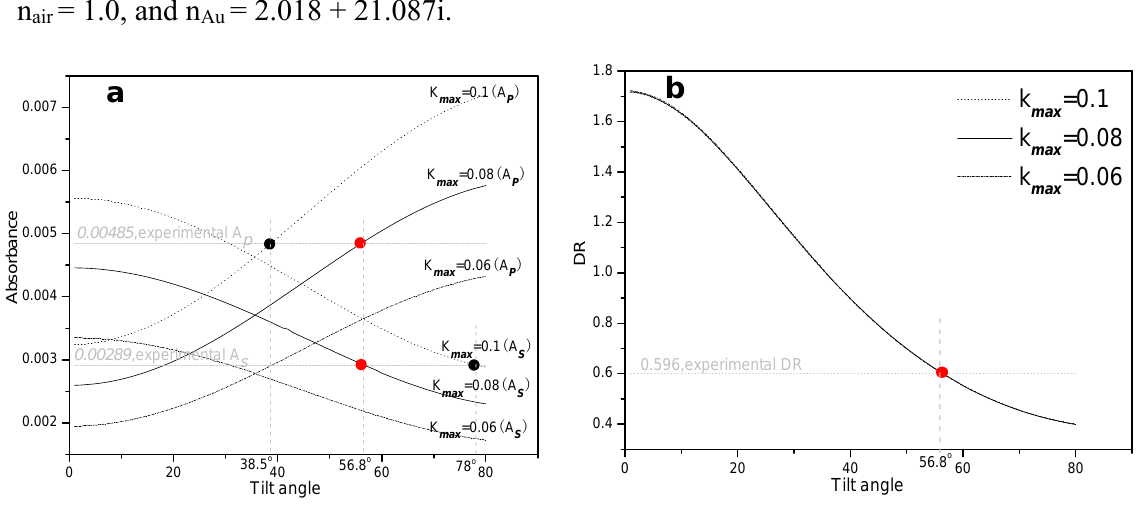
( ) CH  = 2 as = 1.5, n = 3.42, SLBs si